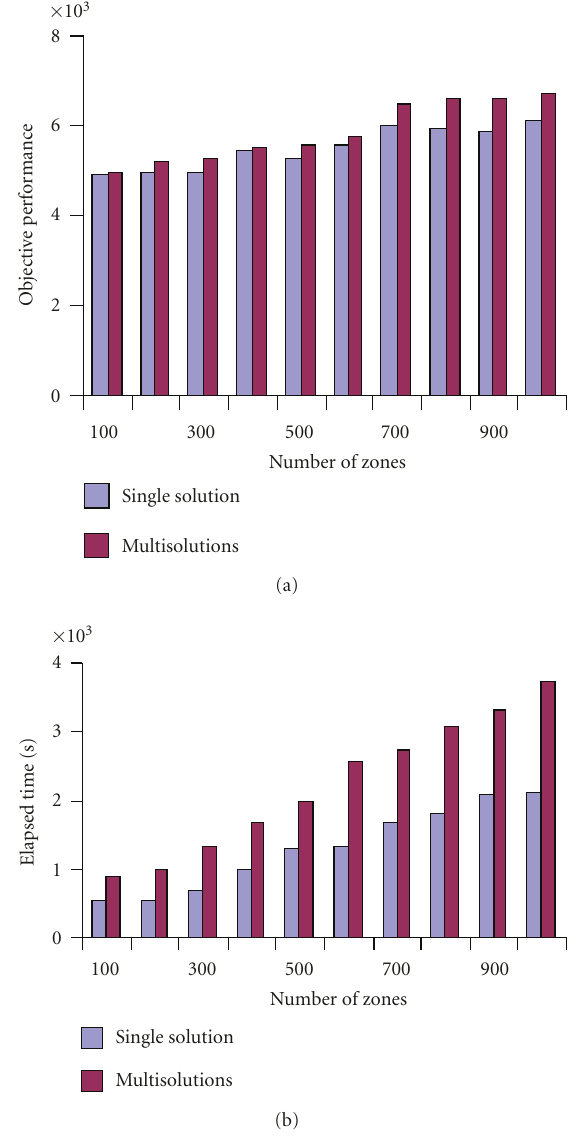
Figure 13: A comparison between single and multiple solution(s) per iteration: (a) objective performance and (b) elapsed time.